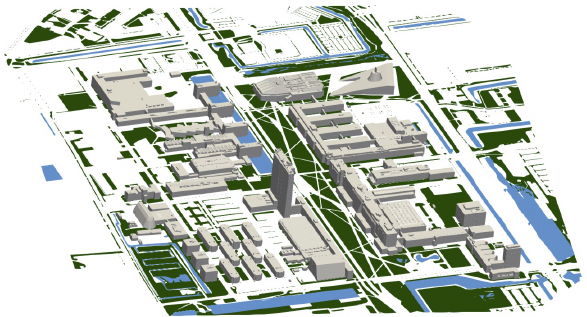
Figure 2. LoD2.2 with semantic surfaces for water (blue) and vegetation (green).